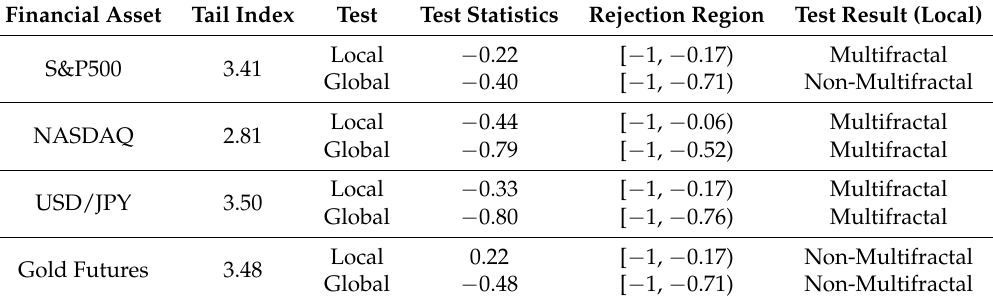
Figure 10. Scaling functions for S&P500, NASDAQ Index, USD/JPY Exchange and Gold Futures Prices the period 28 April 2013 to 3 September 2019. Table 6. Test results among different financial assets during the dot-com bubble (3 January 1994–8 October